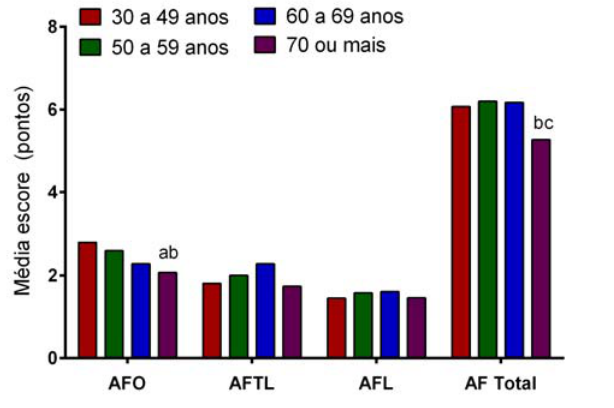
Figura 1. Média de atividade física em cada domínio estratificada por grupos etários. Letras diferentes indicam diferença significante ( post hoc p < 0,05): "a" diferente de 30-49, "b" diferente de 50-59, "c" diferente de 60-69. Legenda: AFO= atividade física ocupacional; AFTL= atividade física de tempo livre; AFL= atividade física de locomoção; AF total; atividade física